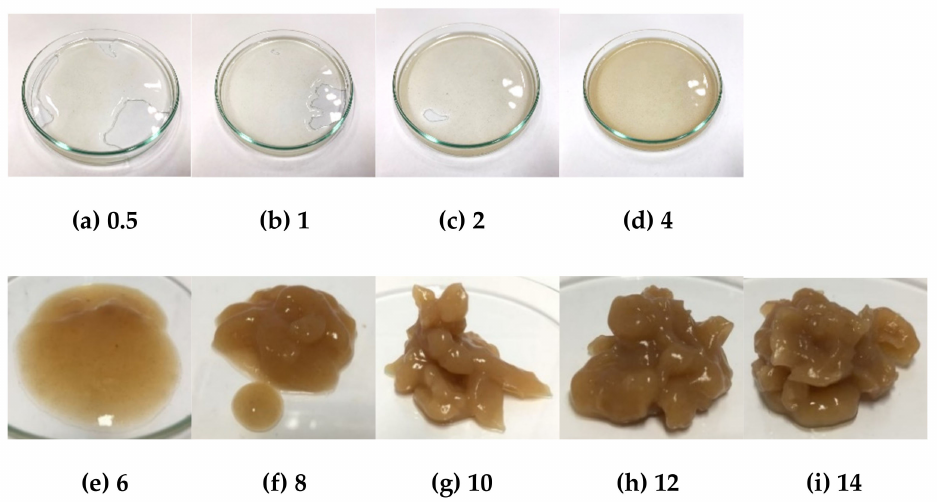
Figure 5. Gelation of HK banana starch at 80 ◦ C at different concentrations where ( a ) 0.5% w / v , ( b ) 1% w / v , ( c ) 2% w / v ,